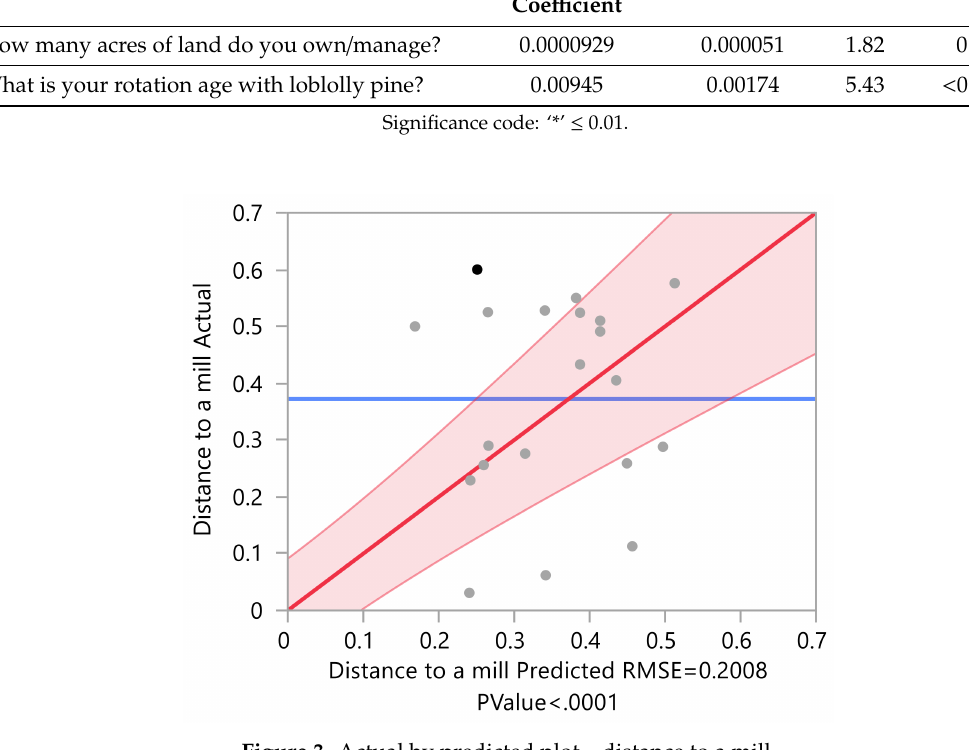
Figure 3. Actual by predicted plot—distance to a